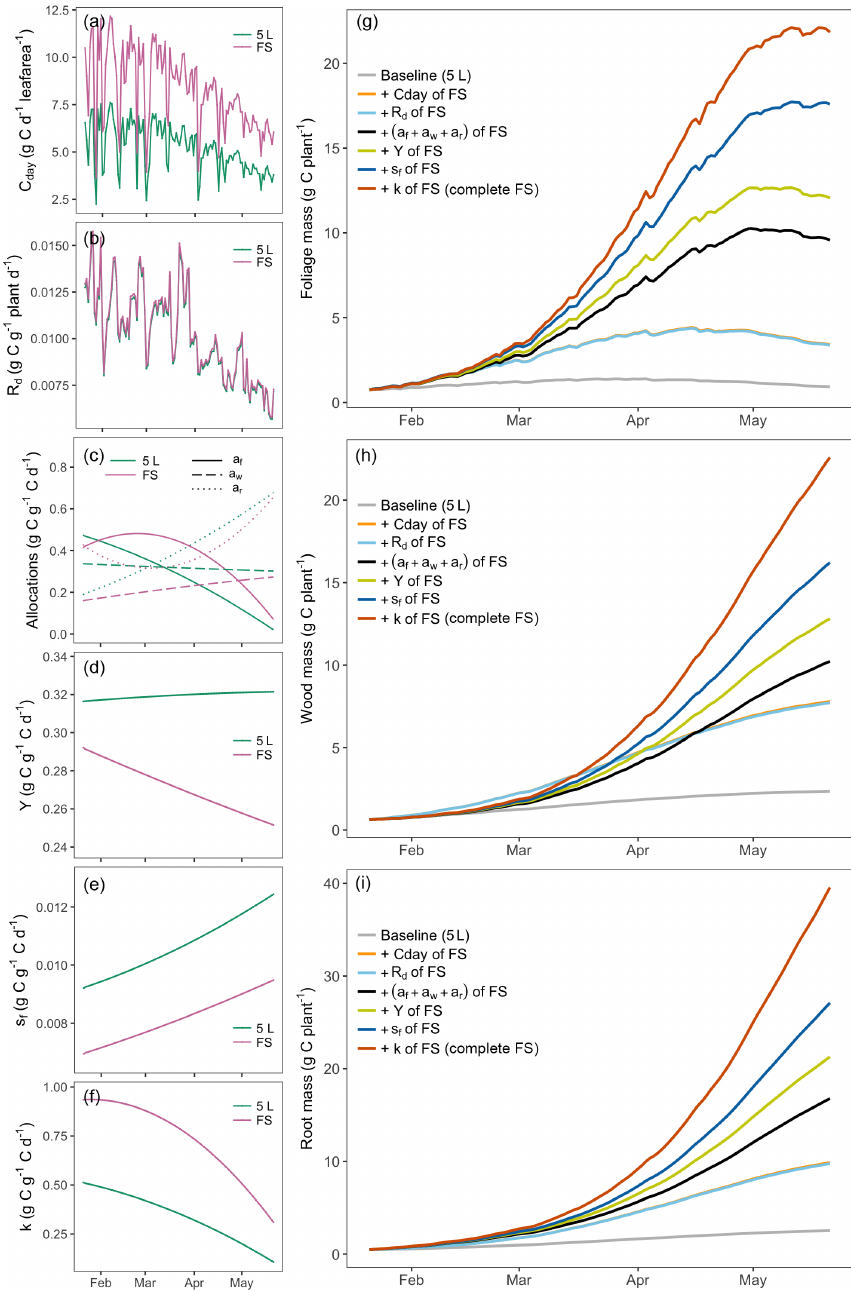
Figure 5. Attribution analysis. Left column (a–f) : changes in inferred parameters. Right column (g–i) : associated impacts on C budgets due to sequential parameter changes from 5L container treatment to that of free seedlings (right column, g–i ). Different colors in the figure indicate the parameter shifts (left column, a–f ) and their associated impacts on C budgets (right column, g–i ). Legend: 5L, highly sink-limited treatment with a container size of 5L; FS, free seedlings without any sink limitation. Note that the orange line is overlain by the light blue line; the small change in maintenance respiration results in a very minor effect on biomass